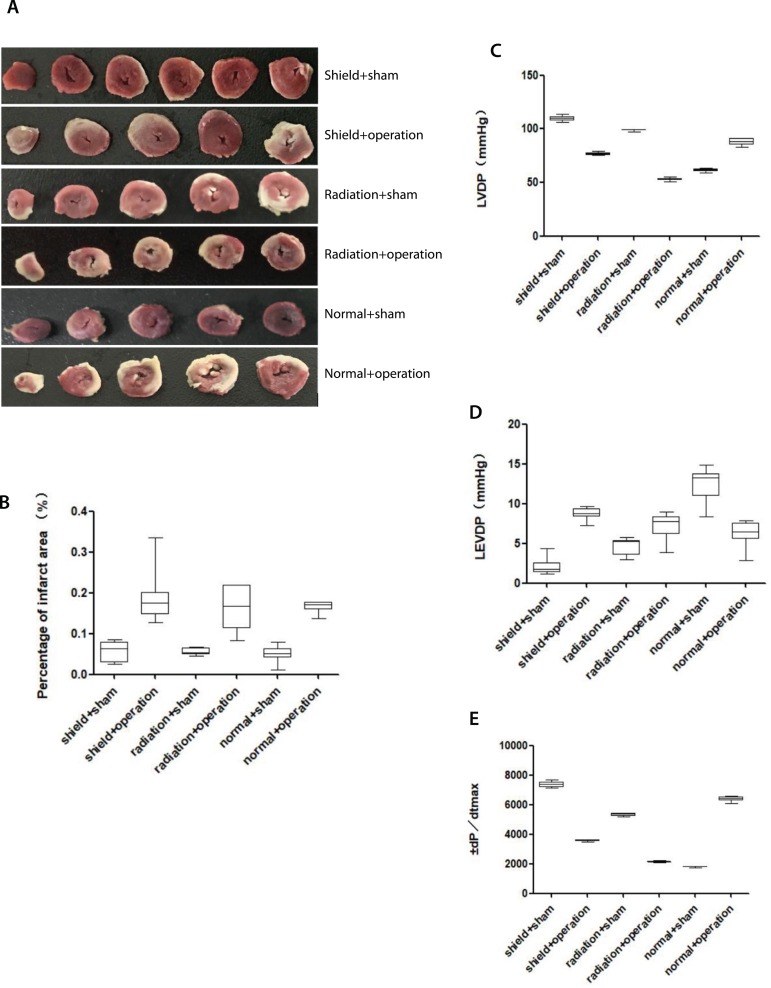
Heart physiological indexes. A) results of TTC staining of the myocardium of rats; B) The infarct areas of the left ventricular tissue were measured by TTC staining (n=6); C, D, and E) the left ventricular pressures were recorded by electrophysiolograph (n=9).LEVDP=left ventricular end-diastolic pressure; LVDP=left ventricular developed pressure; TTC=triphenyl tetrazolium chloride